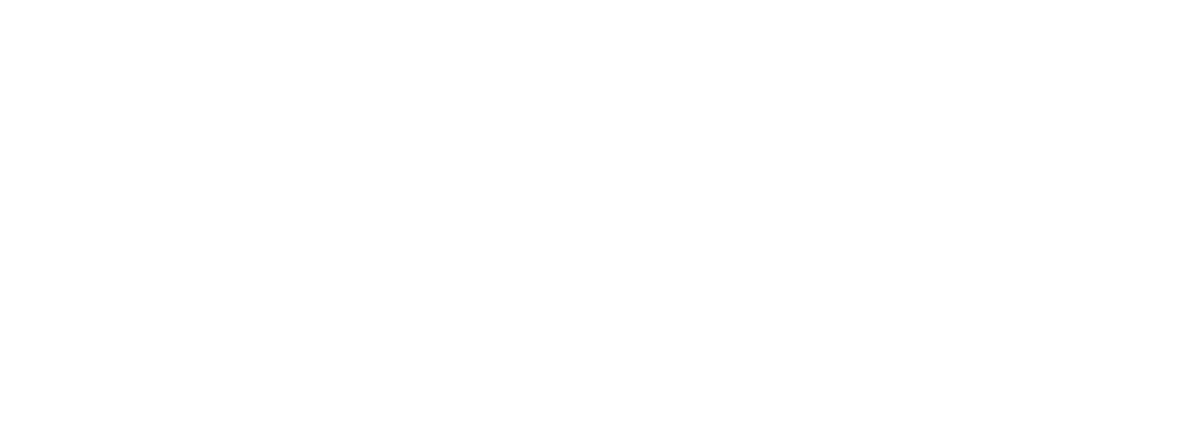
FIGUREA3 | QQ-plot shows the distribution of the p -values of the associations of the SSRs with the phenotypic